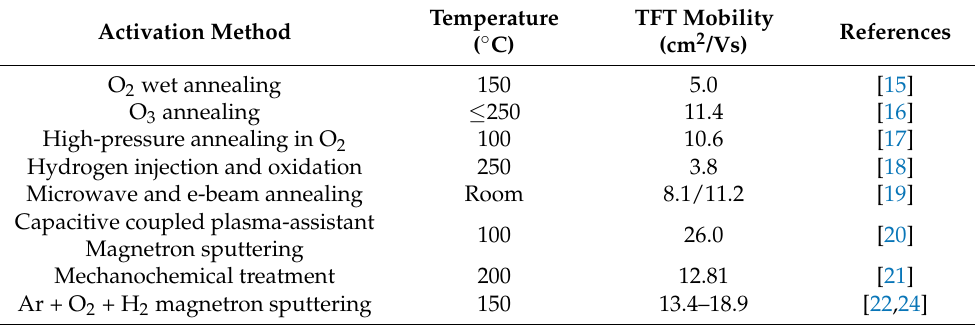
Table 1. Summary of low-temperature activation methods of a-IGZO and TFT